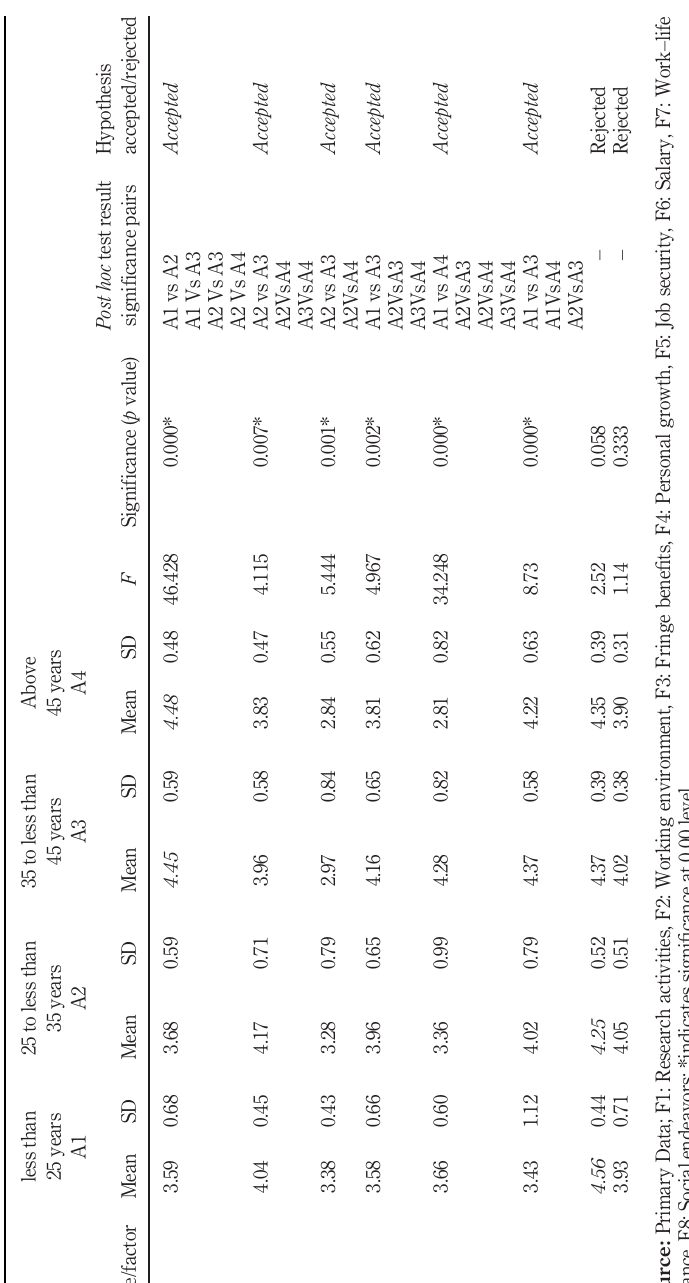
Table VI. Age-wise comparison of